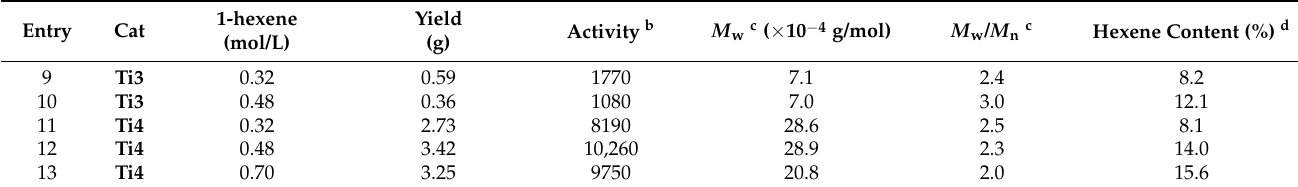
Table 2. Ethylene/1-hexene copolymerization with Ti3 and Ti4 a .